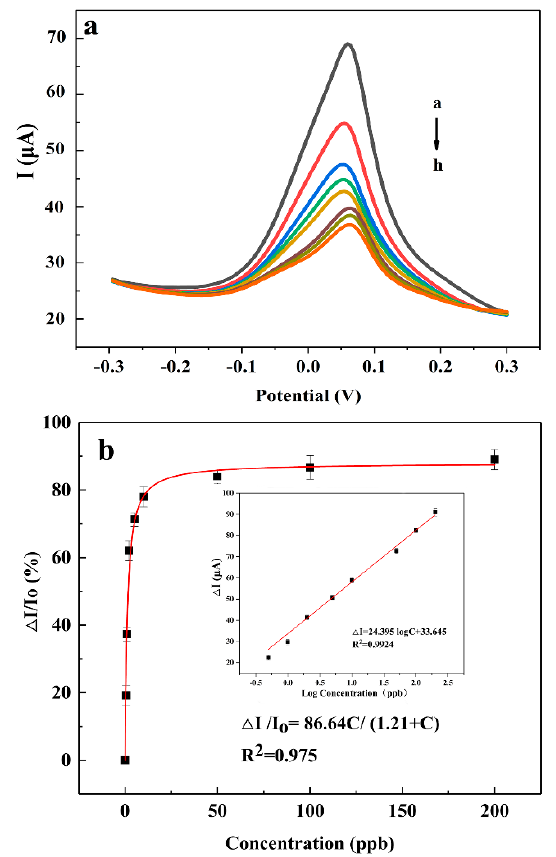
Figure 5. ( a ) Differential pulse voltammetry (DPV) curves of CuAl-LDH/Gr/GCE in 0.2 M pH 5.4 ABS (glyphosate concentrations from a to h, 0.5,1, 2, 5, 10, 50, 100 and 200 ppb; incremental voltage 0.005 V; amplitude 0.05 V; pulse width 0.05 s; sample width 0.025 s and pulse period 0.5 s) and ( b ) the corresponding calibration curve with the Langmuir adsorption fitting curve (the linear curves of the logarithmic value in the above glyphosate concentration and the peak current reduction in the inset).